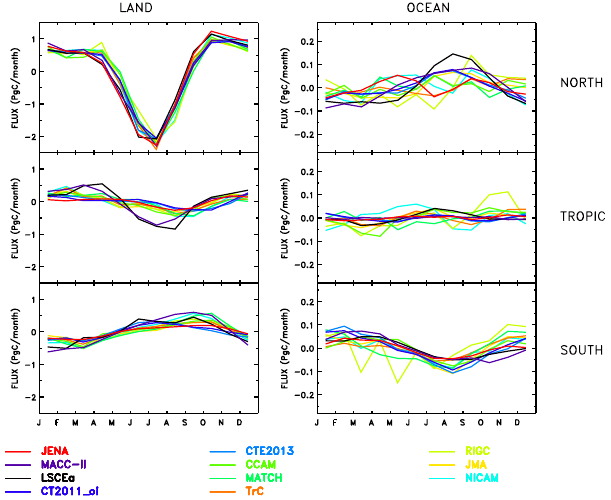
Fig. 9. Mean seasonal cycle of the posterior carbon exchange for the individual participating inversion submissions. Shown here are the natural land (first column) and natural ocean (second column) car- bon exchange aggregated over the Northern Hemisphere ( > 25 ◦ N), the tropics (25 ◦ S–25 ◦ N) and the Southern Hemisphere ( < 25 ◦